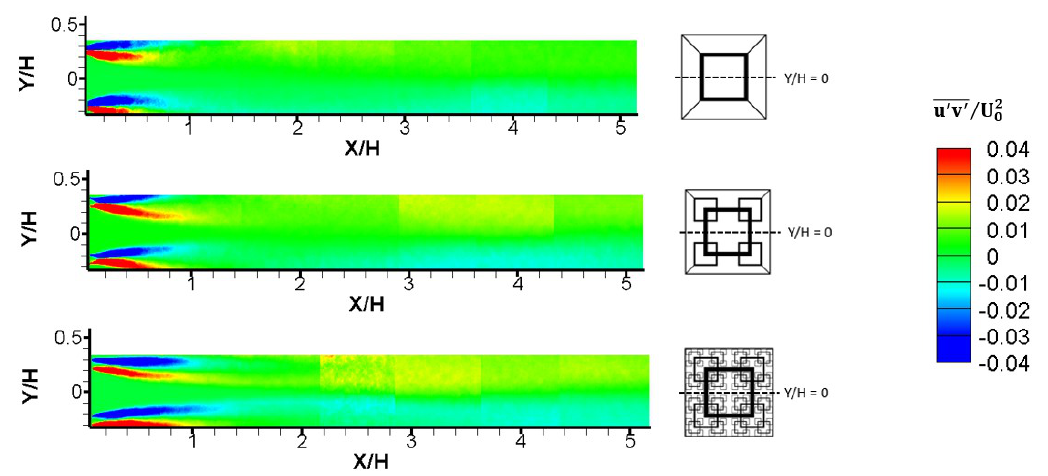
Figure 9. Reynolds shear stress u (cid:48) v (cid:48) / U 02 downstream of a fractal square grid at Re = 3400. FG1, FG2 and FG4 from top to